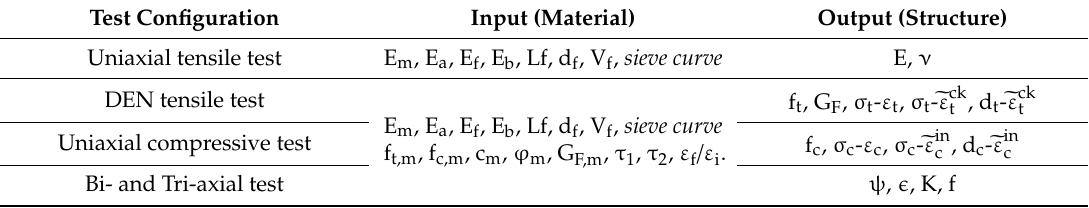
Table 1. Summary of virtual tests with their corresponding inputs and outputs. Subscript: m-mortar, a-aggregate, f-fiber,